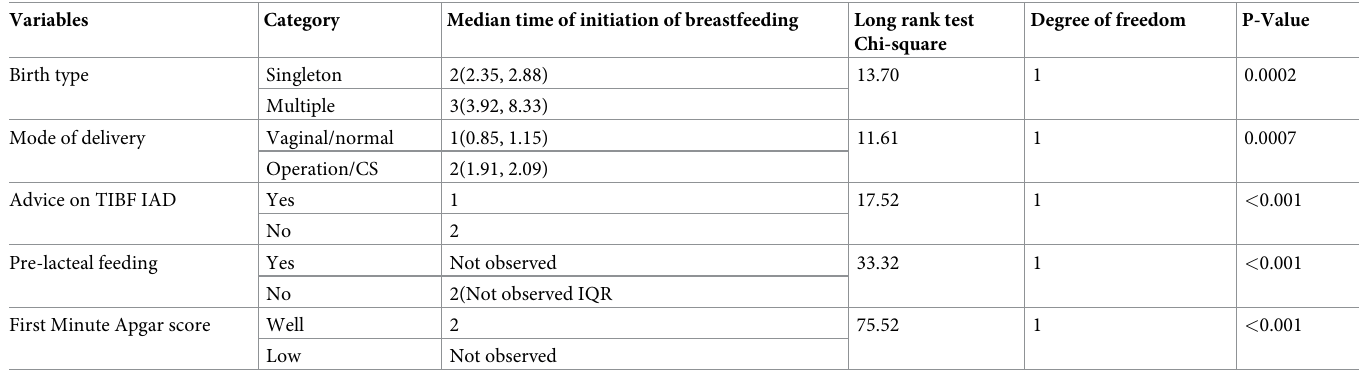
Table 4. Comparison of survival time to initiation of breastfeeding by log-rank test Chi-square among postnatal mothers within 12 hours of giving birth in Debre Markos Comprehensive Specialized Hospital, East Gojjam Zone, North West, Ethiopia, 2020.